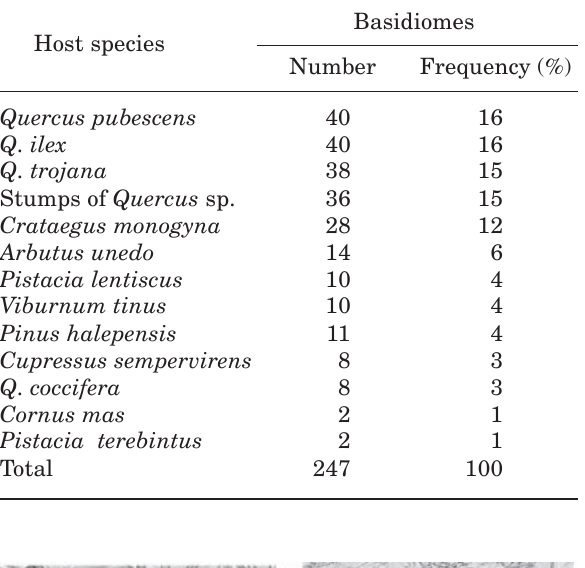
Table 2. Number and frequency (%) of Phellinus torulo- sus basidiomes collected from each host species. Basidiomes Host species